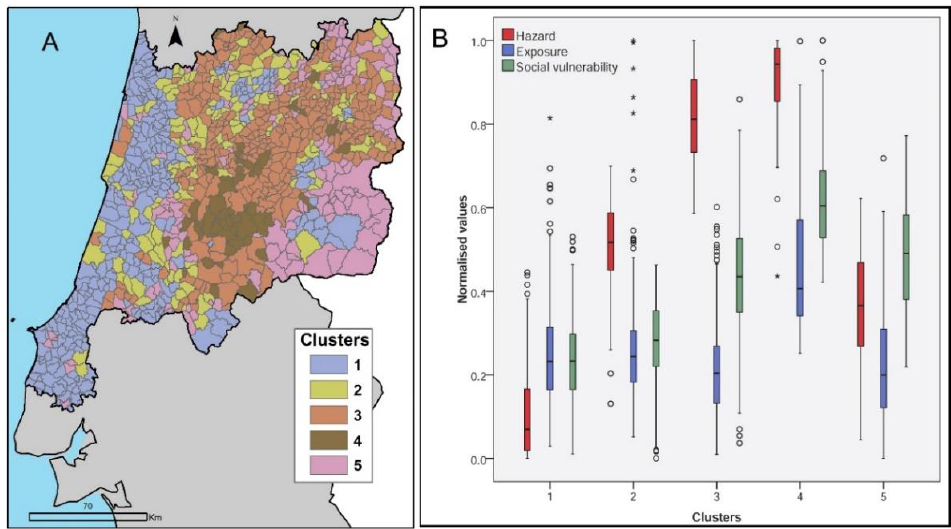
Figure 11. ( A ) Division of the parishes in the study area in five clusters based on hazard, exposure, and social vulnerability levels; ( B ) Distribution of hazard, exposure, and social vulnerability levels among the five clusters. Circles identify potential outliers, defined as situated between 1.5× and 3× the interquartile range below the 1st quartile and above the 3rd quartile. Asterisks identify potential extreme outliers, exceeding 3 times the interquartile range below or above the 1st and the 3rd quartile.